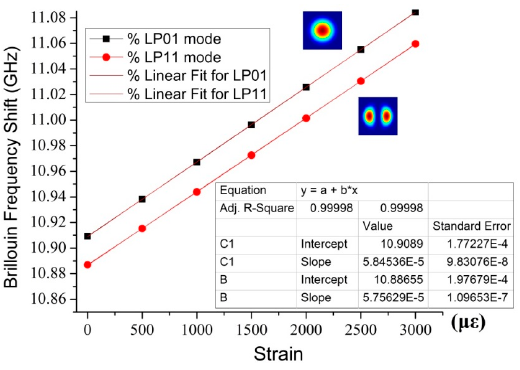
Figure 13. Calibration of strain coefficients for different modes in FMF.